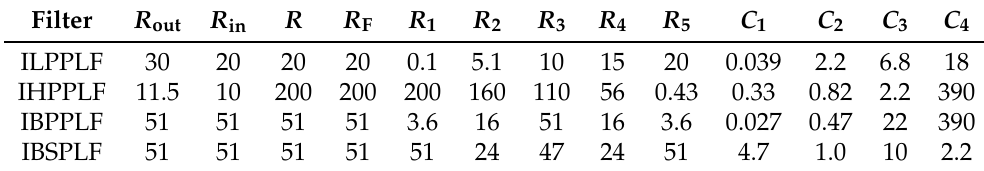
Table 6. Values of the passive components for the realization of the proposed IPLFs ( α = 0.5 ) (Note: All resistances are in k Ω , and all capacitances are in